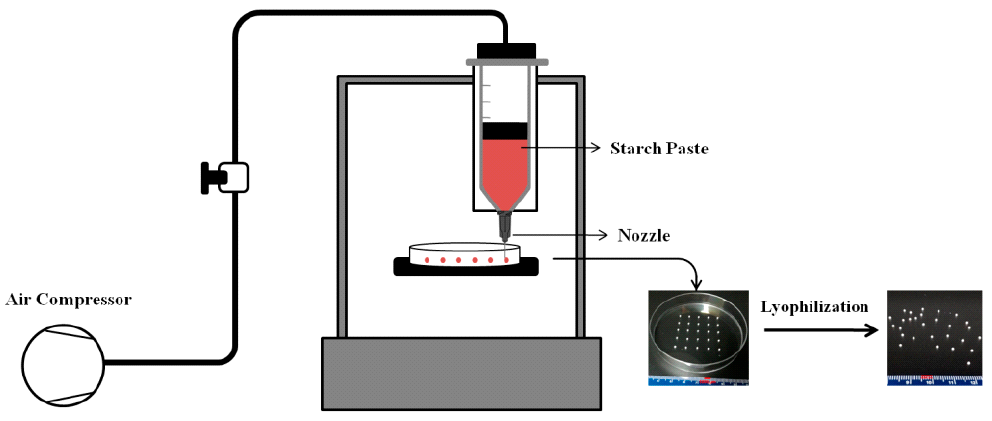
Figure 1. Schematic diagram of the extrusion-based 3D food printing system.